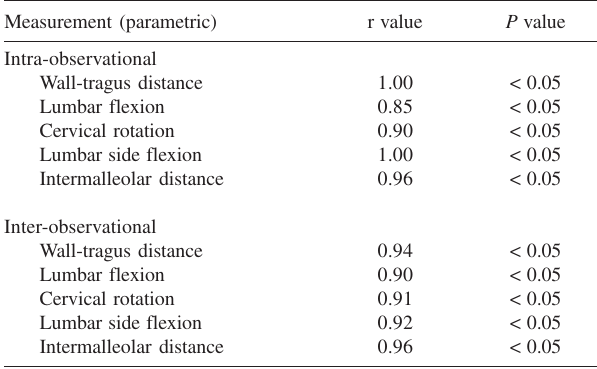
Table 1 - Laboratory and demographic features of 25 consecutive patients with ankylosing spondylitis Demographic and laboratory